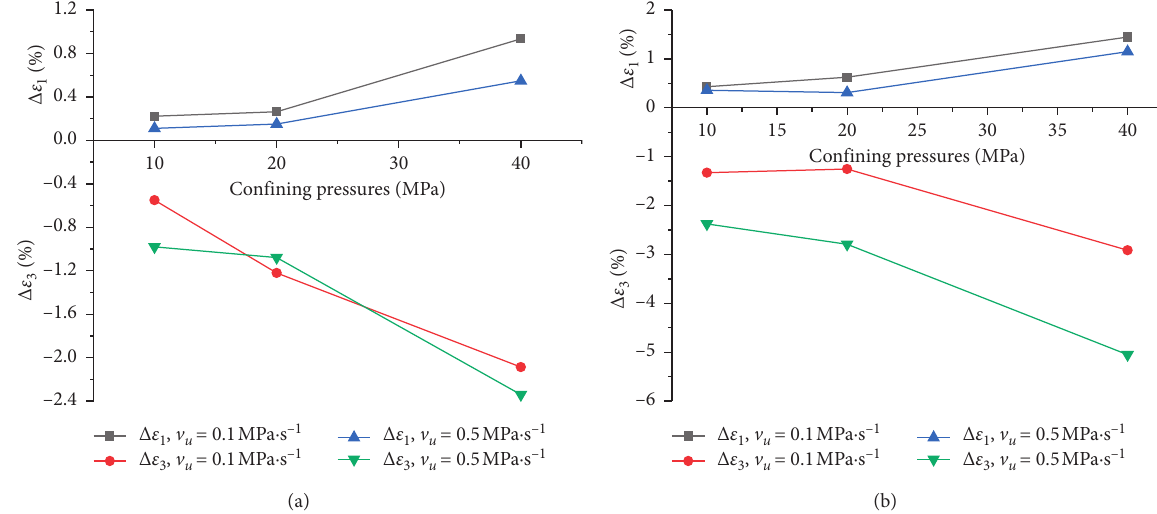
Figure 8: Affection laws of strain increment in the unloading confining-loading axial pressure test: (a) unloading starting point to the peak strength stage; (b) peak strength to the residual strength